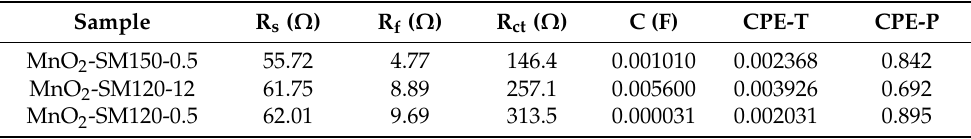
Figure 7. Nyquist plots of MnO 2 -120-0.5, MnO 2 -120-12, and MnO 2 -150-0.5 samples obtained from electrochemical impedance spectroscopy (EIS) measurements in 0.1 M of KOH solution at 1.665 V (vs. RHE) and the inserted is the corresponding equivalent circuit. Table 2. Component values of fitted equivalent circuit based on the Nyquist